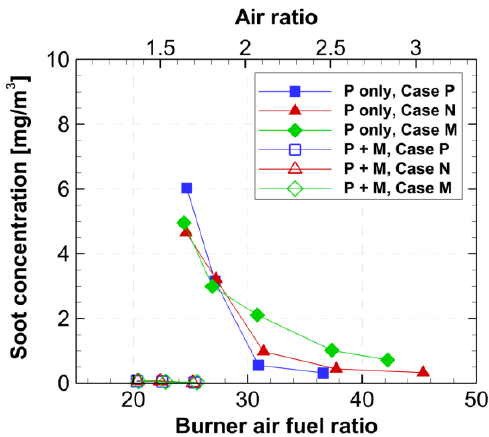
Figure 19. Soot concentration under cruising conditions. (Copyright by ASME — "Effects of Fluidic Control of Air-Flow Distribution on Staged Lean Jet Engine Burner," by Yoshida, Schneider, Hassa, Paper No: GT2016-57453). Paper No: